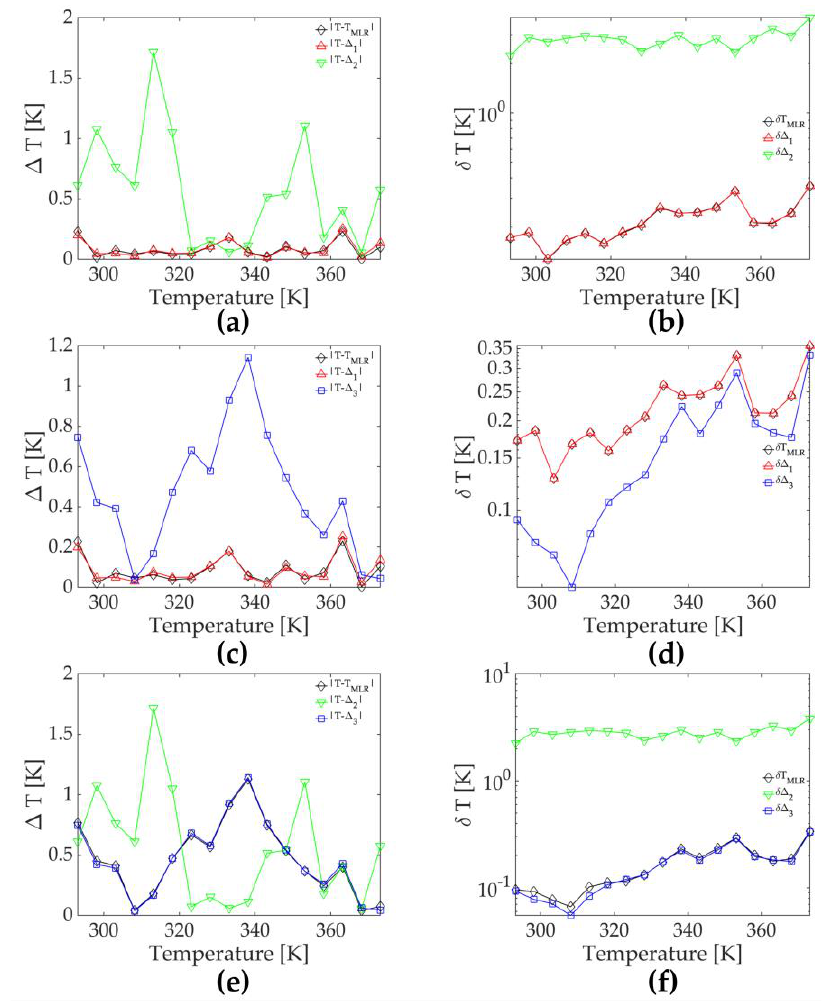
Figure 3. ( a ) The accuracy (Δ T ) and ( b ) the precision (δ T ) of single-parametric ( LIR 1 — red ∆ symbol and line, and LIR 2 — green ∇ symbol and line) and two-parameter (black ♢ symbol and line) temperature readings at different temperatures; ( c ) the accuracy (Δ T ) and ( d ) the precision (δ T ) of single-parametric ( LIR 1 — red ∆ symbol and line, and E 1E — blue □ symbol and line) and two -parameter (black ♢ symbol and line) temperature readings at different temperatures; ( e ) the accuracy (Δ T ) and ( f ) the precision (δ T ) of single-parametric ( LIR 2 — green ∇ symbol and line, and E 1E —blue □ symbol and line) and two-parameter temperature (black ♢ symbol and line) readings at different temperatures.